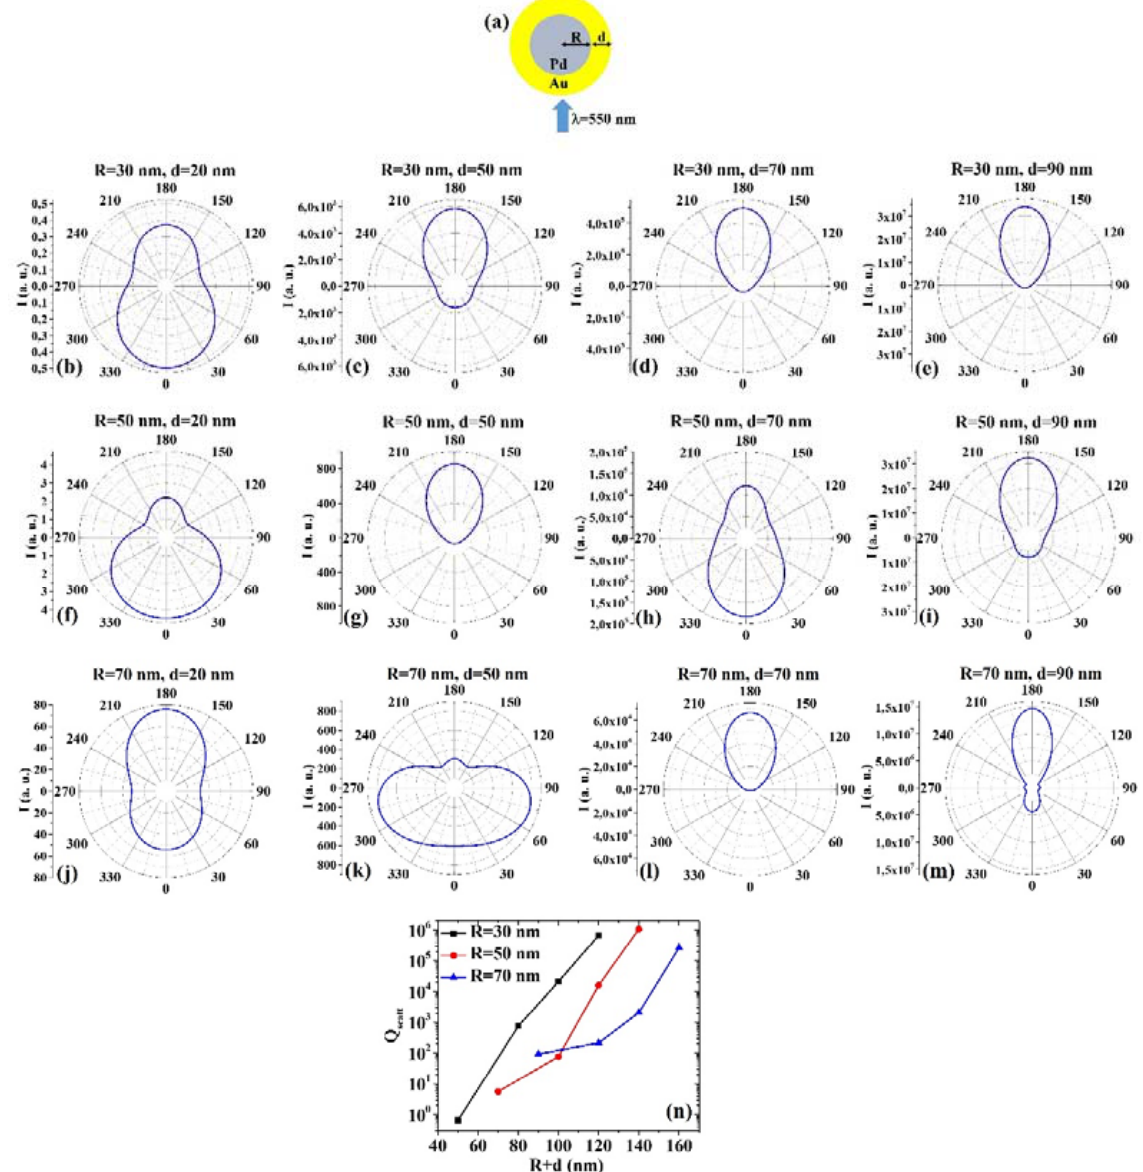
Figure 6. ( a ) Scheme of the structure of the simulated Pd/Au core/shell spherical particle with core radius R and shell width d and electromagnetic radiation of wavelength λ = 550 nm impinging on the particle from 0°. ( b – m ) Calculated polar diagrams for the intensity of the scattered light from the Pd/Au core/shell spherical particle changing the Pd core radius R and the Au shell width: ( b – e ) R = 30 nm and d = 20 nm ( b ), d = 50 nm ( c ), d = 70 nm ( d ), d = 90 nm ( e ); ( f – i ) R = 50 nm and d = 20 nm ( f ), d = 50 nm ( g ), d = 70 nm ( h ), d = 90 nm ( i ); ( j – m ) R = 70 nm and d = 20 nm ( j ), d = 50 nm ( k ), d = 70 nm ( l ), d = 90 nm ( m ). ( n ) Calculated scattering efficiency for the light (wavelength λ = 550 nm) scattering process of the Pd/Au spherical particle fixing the Pd core diameter (R = 30 nm black dots, R = 50 nm red dots, R = 70 nm blue dots) and increasing the Au shell width d from 20 nm to 90 nm.